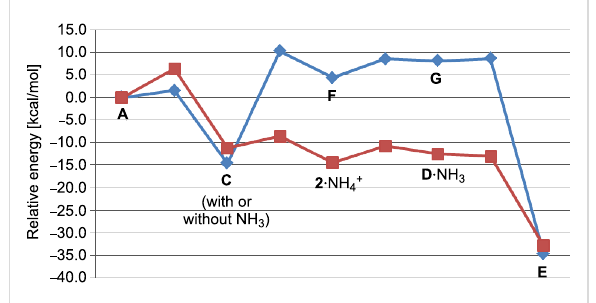
Figure 8: Predicted energetics for the conversion of A to E in the absence (blue) and presence (auburn) of ammonia. Relative energies shown (kcal/mol) were calculated at the mPW1PW91/6-31+G(d,p)// B3LYP/6-31+G(d,p) level. Energies for the pathway with ammonia are relative to those for an A ·NH 3